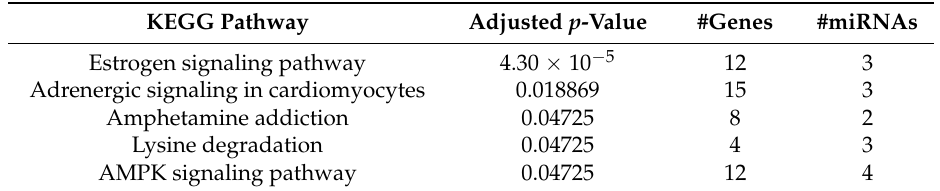
Enrichment pathways of predicted target genes of four key exosomal miRNAs for AZD6244